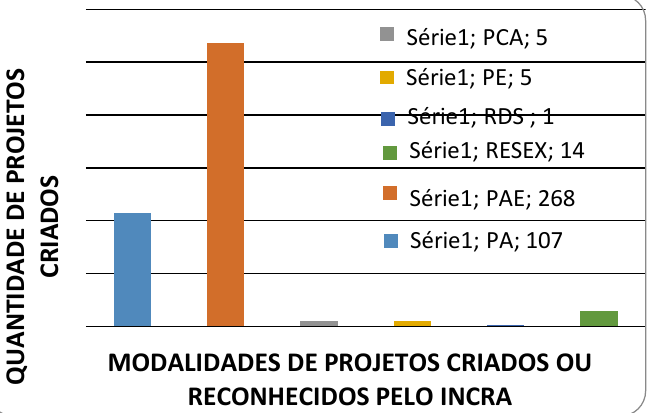
Fonte: Sistema de Informações de Projetos de Assentamento da Reforma Agrária – INCRA